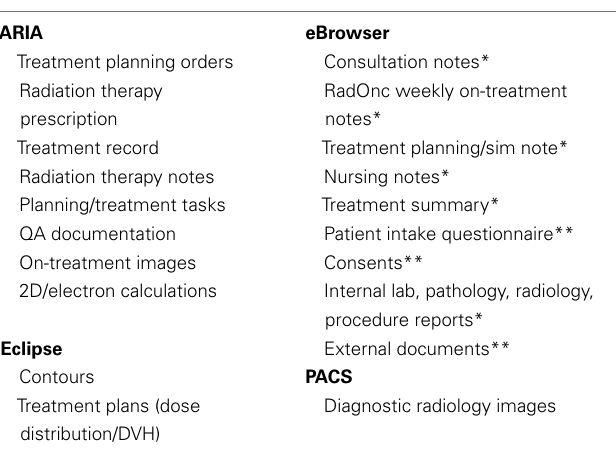
Table 6 | Location of specific documents in the virtual radiation oncology